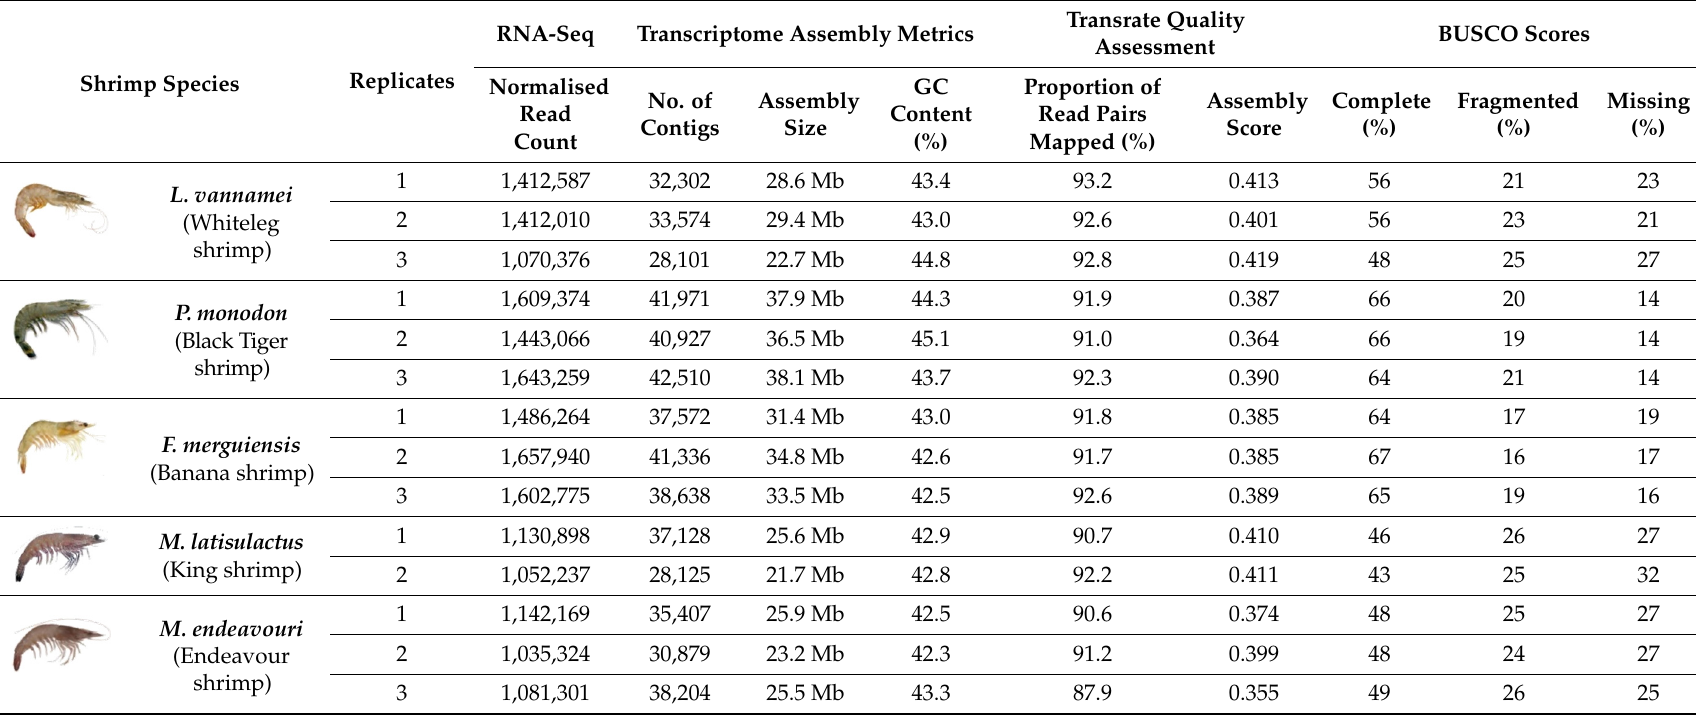
Table 1. Results of Trinity transcriptome assembly, TransRate, and BUSCO. Shrimp species name (common name) and their 1–3 biological replicates are shown with the transcriptomes’ number of contigs and assembly size after assembly by Trinity. TransRate and BUSCO scores (C: Complete, F: Fragmented, M: Missing) of each transcriptome are indicated.